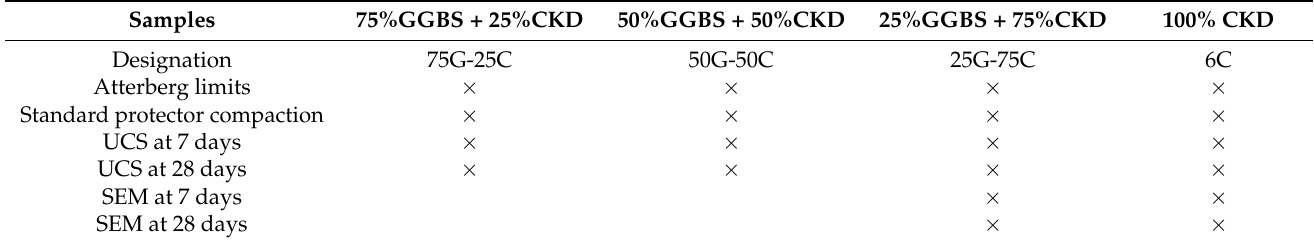
Table 5. Summary of the test program and performed test for the first stage (percentage values were provided in terms of the mass of stabilizing